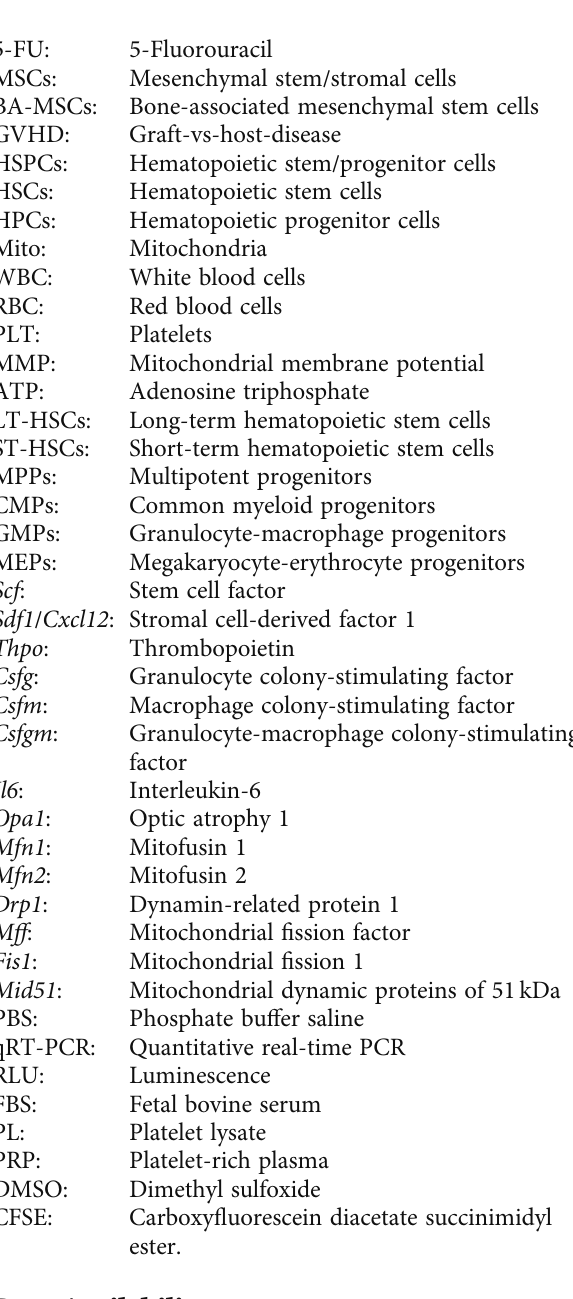
Supplementary Figure S1: analysis of time and concentration of 5-FU in incubation with BA-MSCs to induce apoptosis in vitro . Supplementary Figure S2: changes of WBC, RBC, and PLT in peripheral blood of 5-FU-induced myelosup- pression mice. Supplementary Figure S3: identi fi cation of platelet-derived mitochondria and evaluation of therapeutic e ffi cacy in the treatment of 5-FU-injured BA-MSCs. Supple- mentary Figure S4: schematic of platelet-derived mitochon- dria to treat BA-MSCs with 5-FU injury. Supplementary Table S1: primer sequences in quantitative real-time